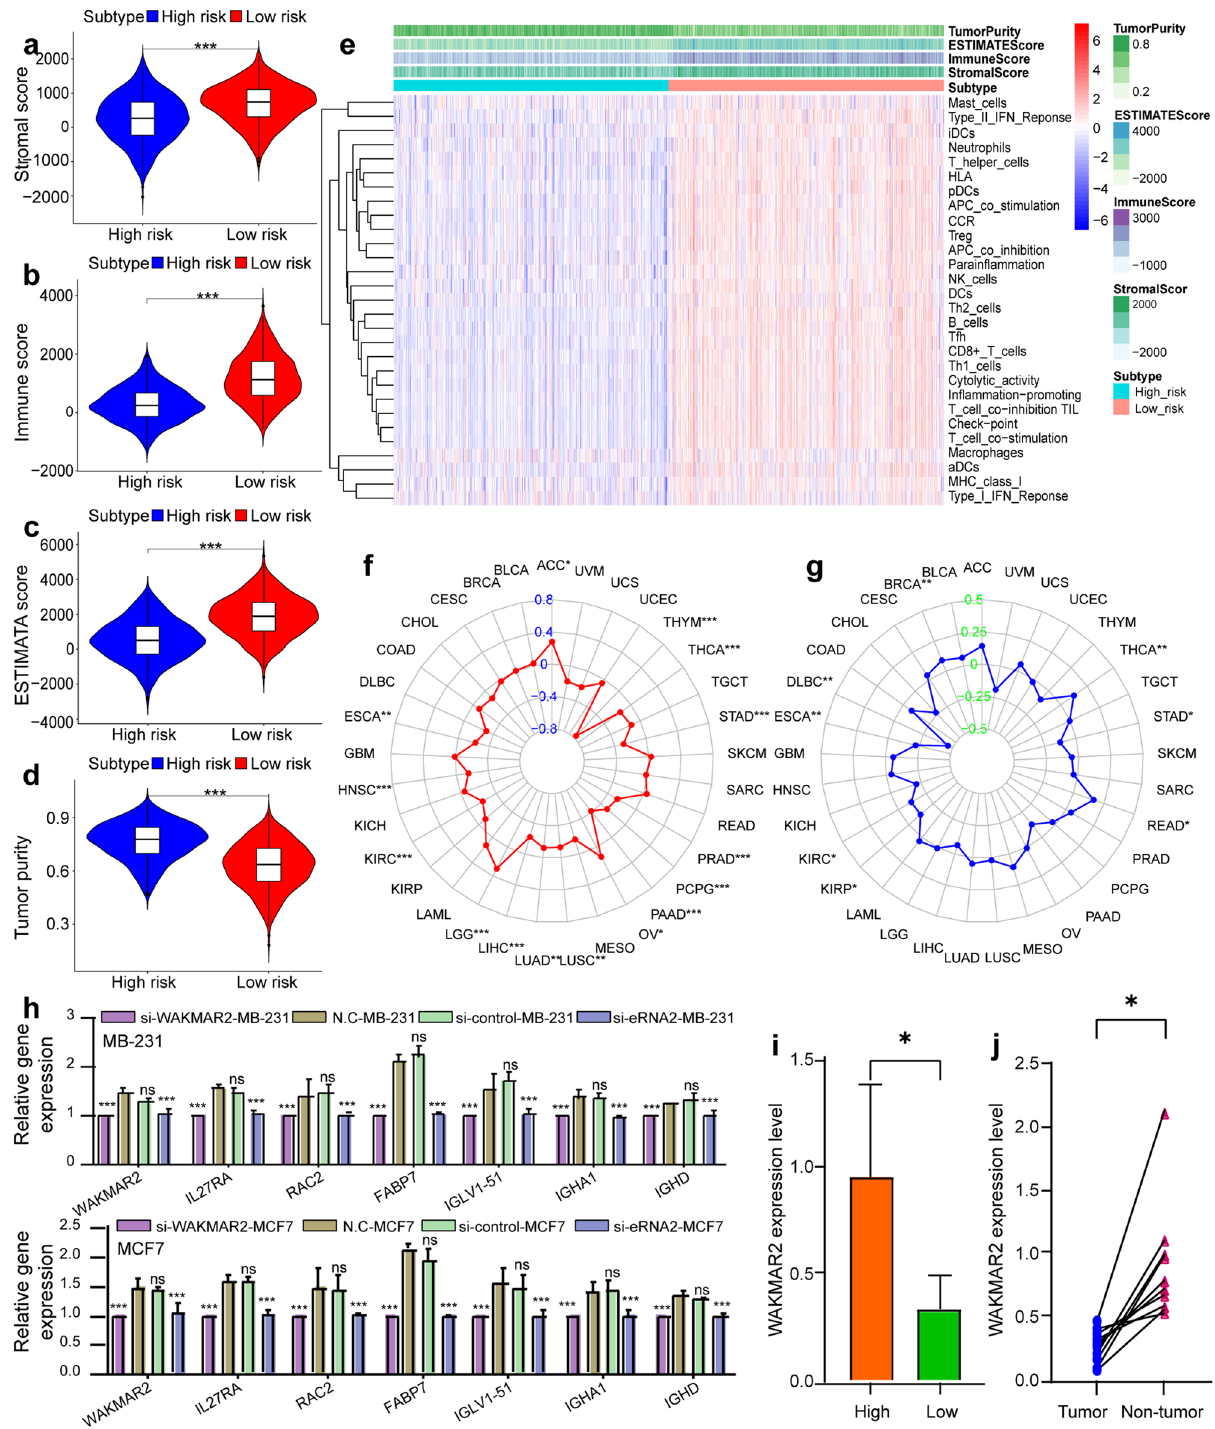
Figure 7. WAKMAR2 expression with tumour microenvironment (TME) relevance for invasive breast cancer (IBC) patients. IBC samples were divided into high-risk (blue band) and low-risk clusters (red band). The assessment of infiltration clusters in the TME was clustered into a stromal score ( a ), an immune score ( b ), an estimate score ( c ), and tumour purity ( d ). ( e ) ssGSEA results show the detailed immune infiltration landscapes of different clusters. Correlation between WAKMAR2 expression and tumour mutation burden ( f ) and microsatellite instability ( g ) in pan-cancer ( h ). Expression levels of WAKMAR2 and its targets after WAKMAR2 knockdown. ( i ) WAKMAR2 expression in higher and lower immunity groups, where “High” stands for the higher immunity group and “Low” stands for the lower immunity group. ( j ) WAKMAR2 expression in IBC and normal